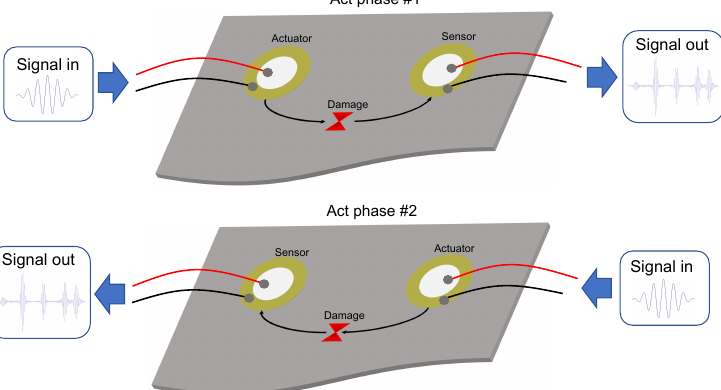
Figure 11. Structural monitoring procedure implementing different actuation